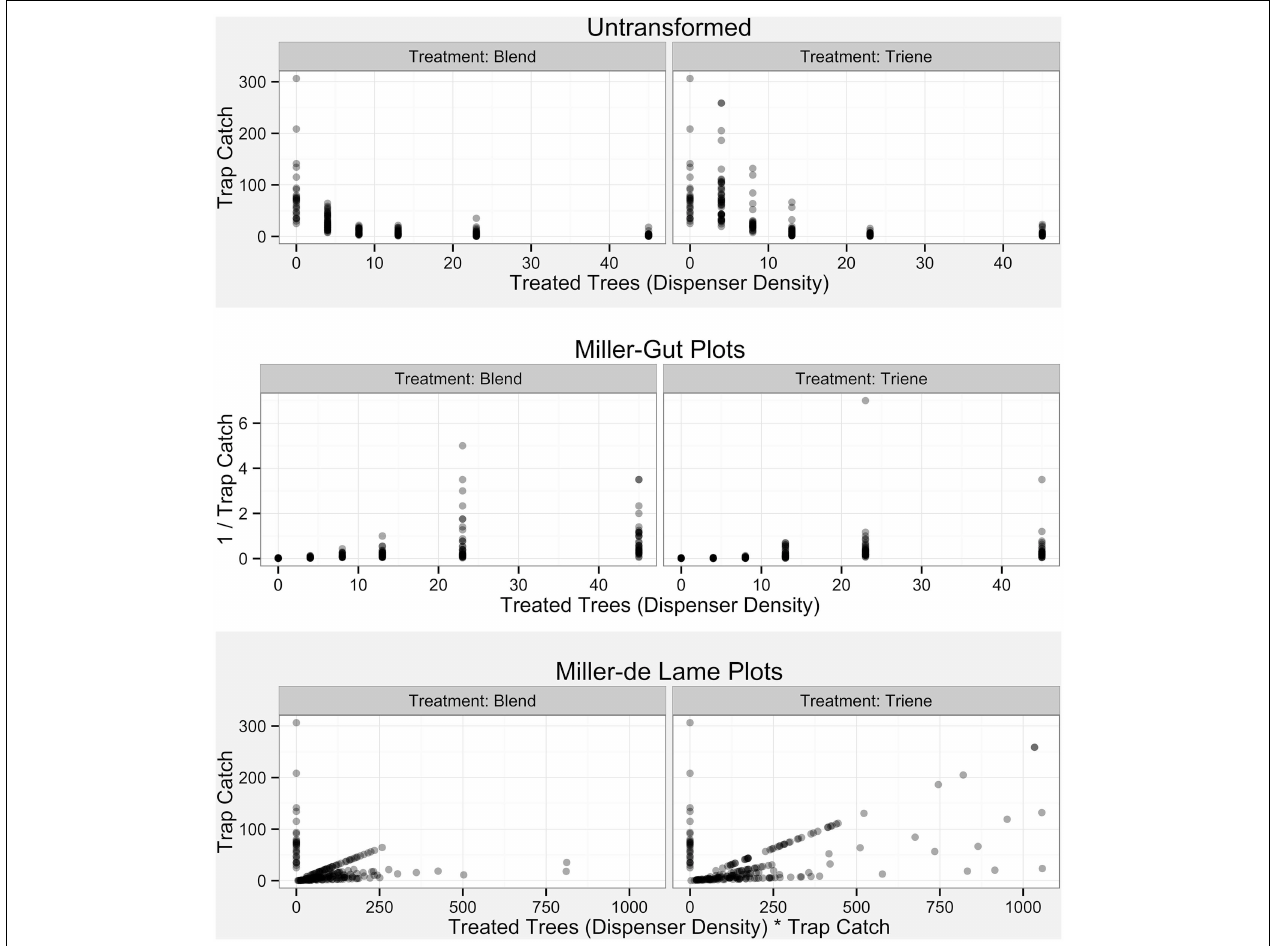
FIGURE 4 | Raw Data from Field Trials by treatment and in accordance with diagnostic plots from Miller et al. (2006a). Transparent points denote specific observations; more opaque points indicate overlap of many points.